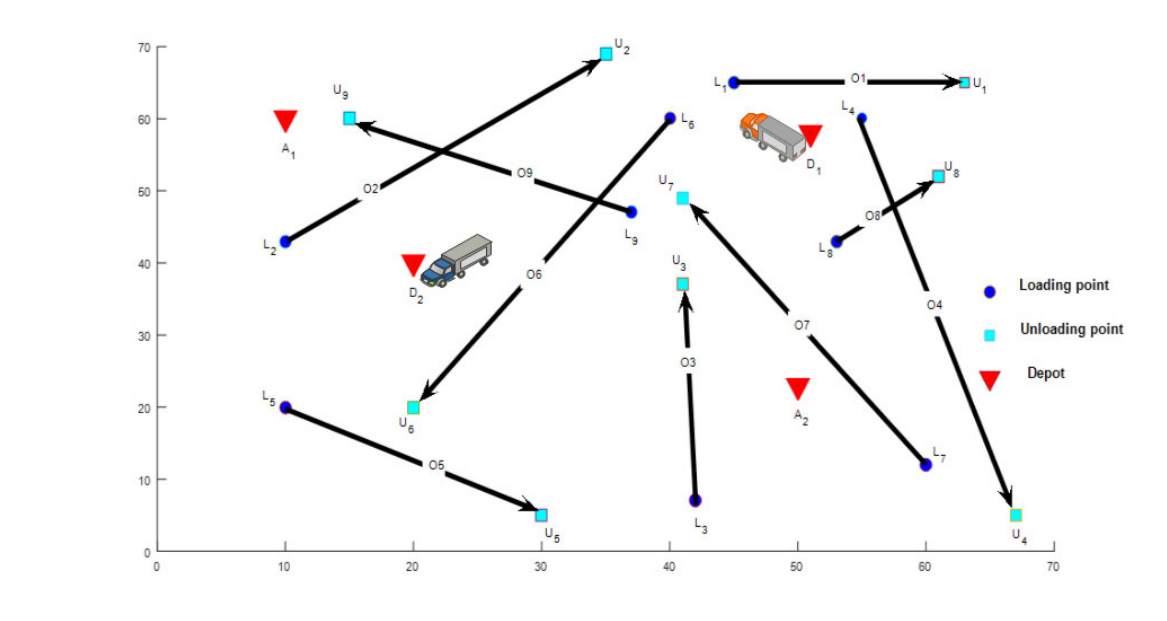
Fig. 1. An illustration of